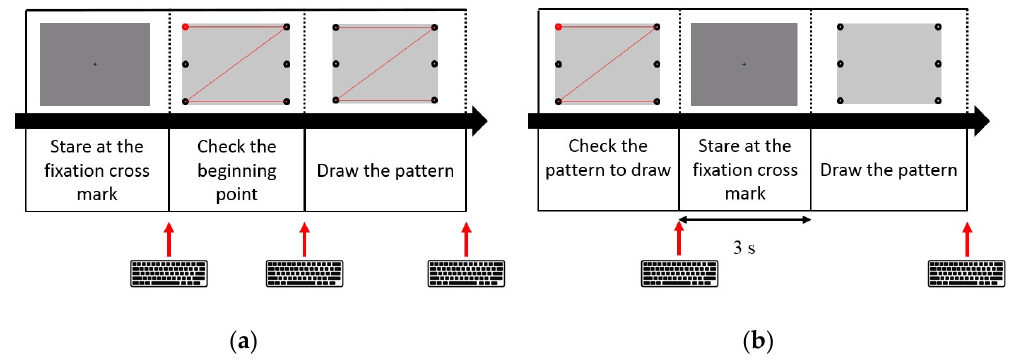
Figure 7. Schematic illustration of the experimental procedures: ( a ) Session to practice eye drawing of patterns; and ( b ) Session to record the EOG signals. The image of a keyboard implies that a user’s response is required to proceed to the next step.